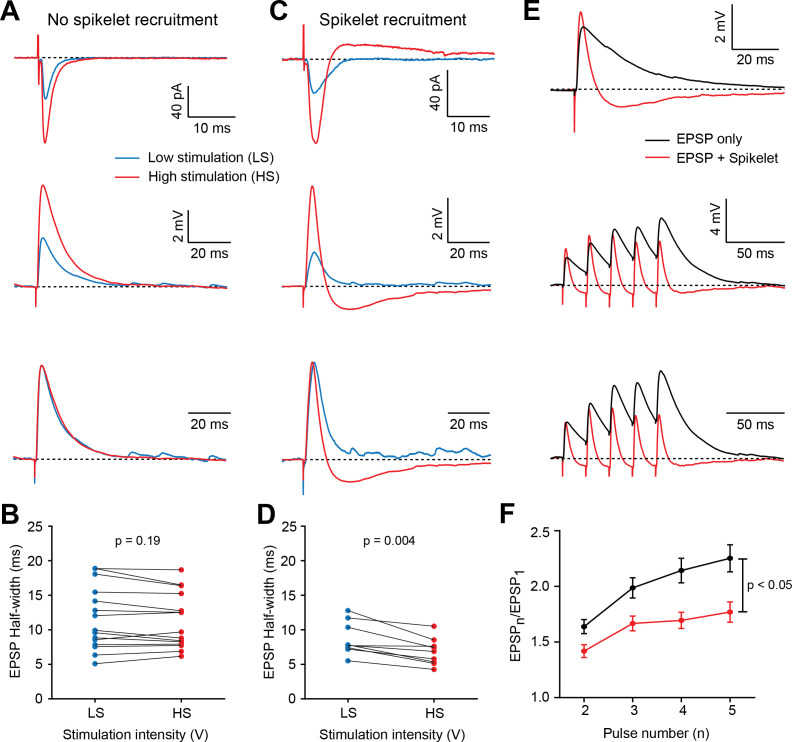
Feed-forward (FF) recruitment of spikelets narrows excitatory postsynaptic potential (EPSP) width and dampens temporal summation.(A) Top, voltage-clamp recordings of PF-mediated synaptic responses in a representative BC in response to low stimulation intensity (LS – blue traces) and high stimulation intensity (HS – red traces). Increasing stimulation intensity leads to increased peak amplitude of excitatory postsynaptic currents (EPSCs), with no additional recruitment of spikelets. Middle, current-clamp recording of the same cell, showing that increasing stimulation intensity increased the amplitude but not the half-width of the normalized EPSPs (bottom). Traces are averages of 20 to 30 trials. (B) Summary plot showing no increase in half-width of EPSPs if no outward current was observed in voltage clamp (p=0.19, Wilcoxon matched-pairs signed rank test, n = 15 stimulation sites over 12 cells). (C) Example cell in which increasing the stimulation intensity recruits an additional spikelet, observed in voltage clamp (top) and current clamp (middle). The half-width of normalized EPSPs was shortened. (D) Summary plot showing a decrease in half-width of EPSPs if outward currents were observed in voltage clamp (p=0.004, Wilcoxon matched-pairs signed rank test, n = 9 sites from 8 cells). (E) Top, superimposed averaged postsynaptic responses (n = 30 trials) from two different cells: one recorded in response to LS, and another in which the direct EPSP is followed by a spikelet-induced hyperpolarization (red) and the other is not (black). Middle, EPSPs evoked by a 50 Hz stimulus train in the same cells as above. Note the decreased temporal summation in the group where spikelets are present. (F) Summary plot showing relative EPSP amplitudes in response to all five stimuli for stimulation sites that did (red) or did not (black) evoke spikelets (Two-way repeated measures ANOVA, column factor (with versus without spikelet): p=0.004; interaction factor (difference in curve shape with stimulus number): p=0.001; EPSP only: n = 27 stimulation sites over 16 cells, EPSP with spikelet: n = 22 sites over 17 cells). See also Figure 7—source data 1.Figure 7—source data 1.Feed-forward(FF)recruitment of spikelets narrowsexcitatory postsynaptic potential (EPSP)width and dampens temporal summation.